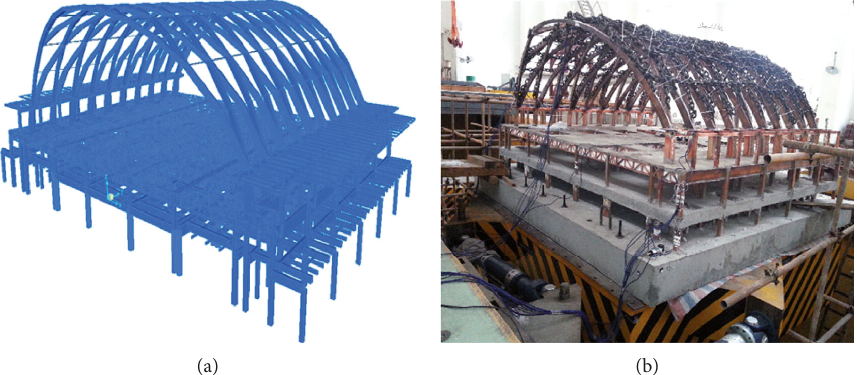
Figure 15: Shake table test with high-speed railway station specimen. (a) Numerical model; (b) test